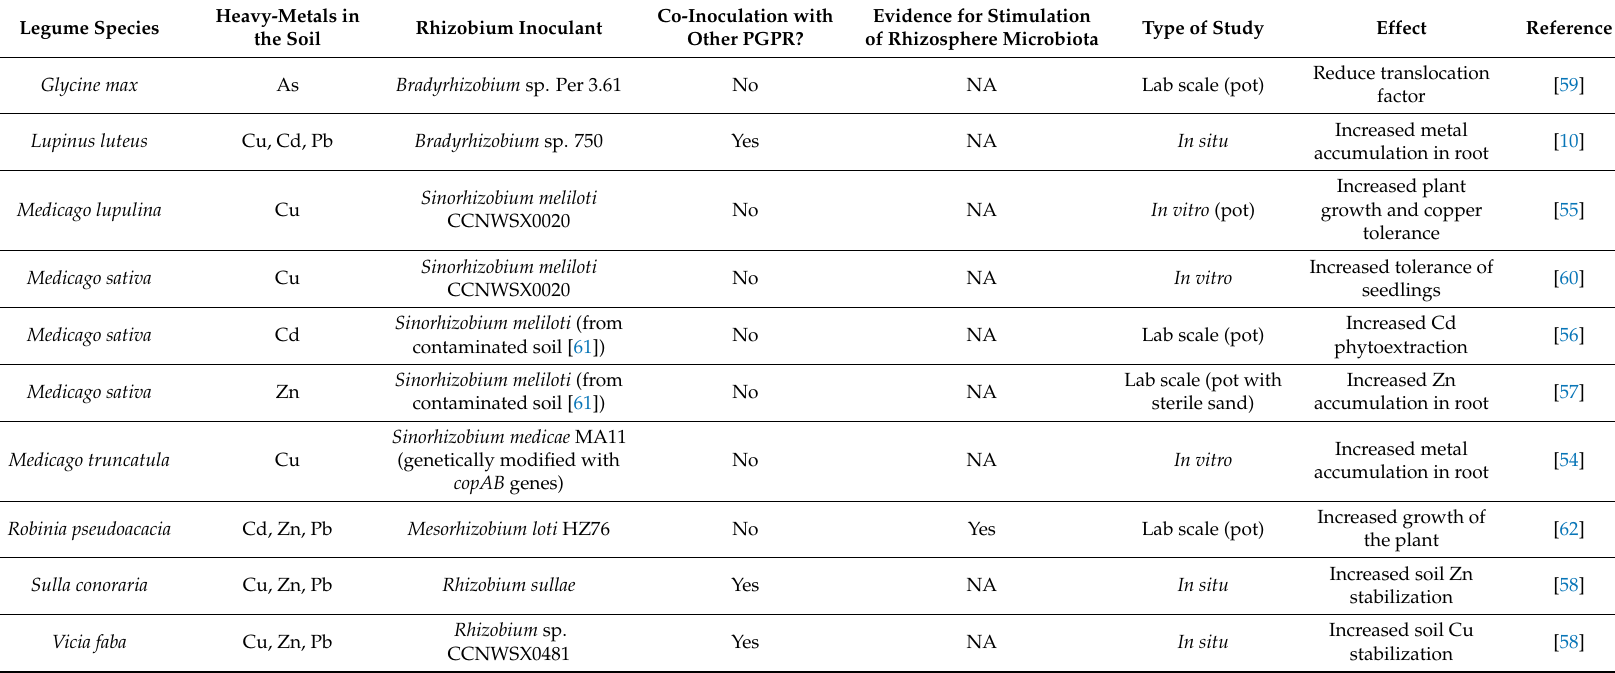
Table 1. Studies of phytoremediation mediated by rhizobium-inoculated legumes. NA, not